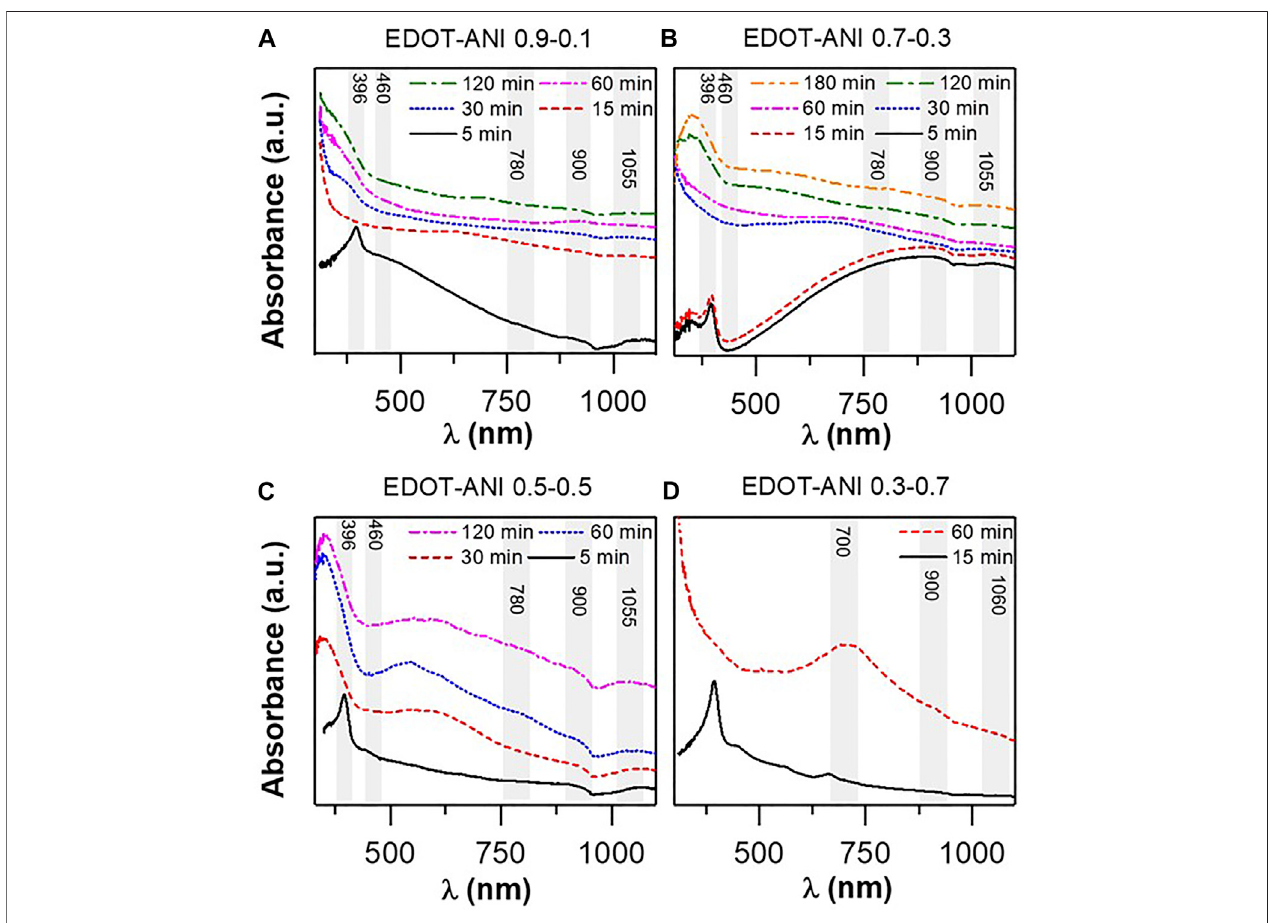
FIGURE 2 | UV-vis spectra: (A) EDOT-ANI 09 – 0.1 polymerization monitoring, (B) EDOT-ANI 0.7 – 0.3, (C) EDOT-ANI 0.5 – 0.5, (D) EDOT-ANI 0.3 – 0.7.